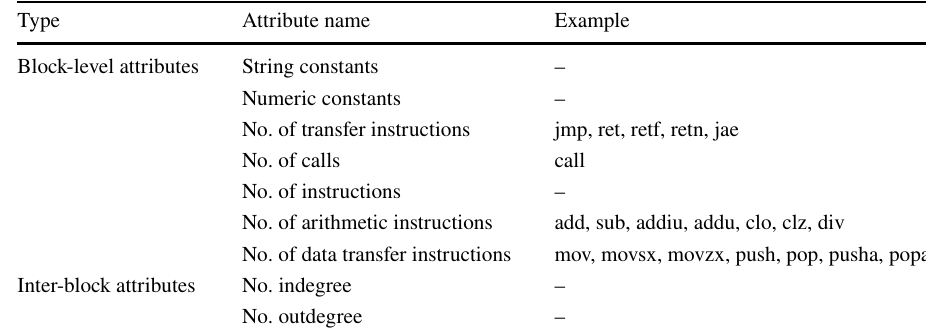
Table 2 Features used by structural attribute embedding